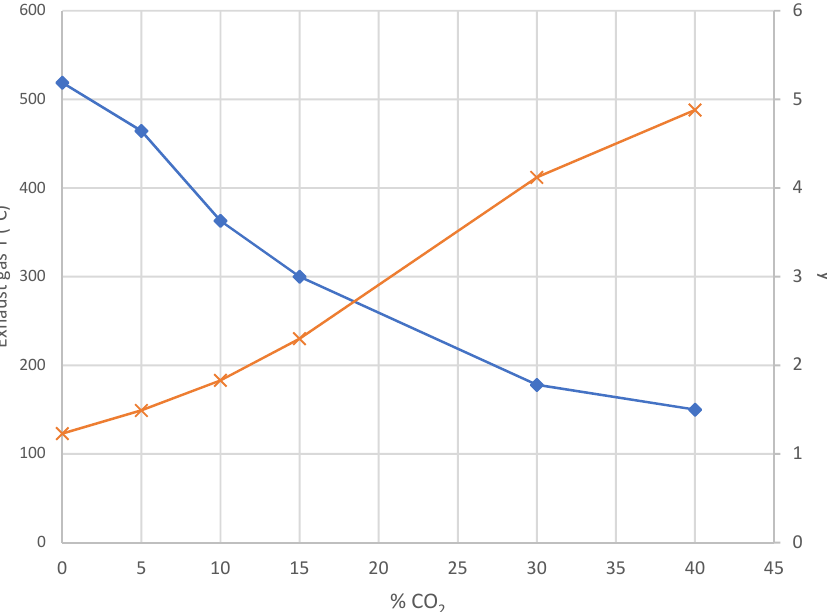
Figure 8. Effect of CO 2 addition to the exhaust gas temperature and the combustion lambda.